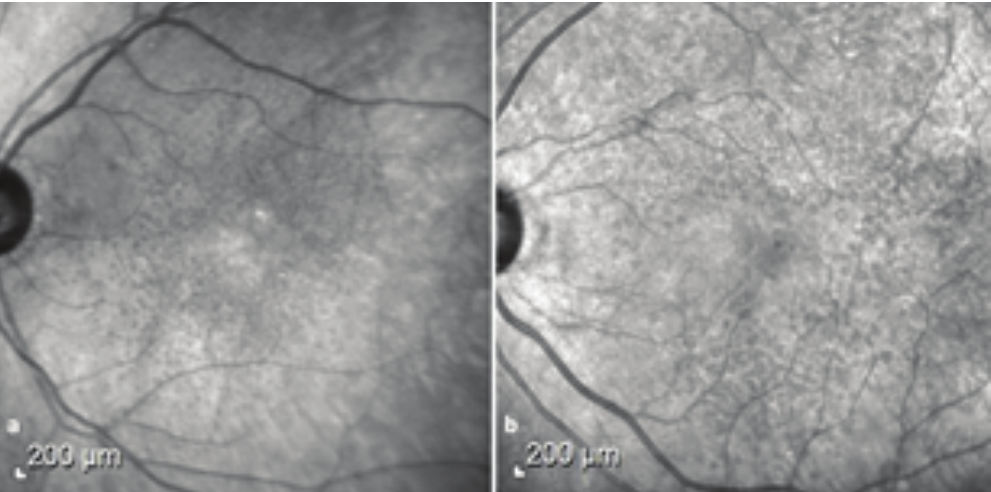
Figure 4. Near infra-red reflectance imaging of SDD. (a) Numerous clearly visible perifoveal SDD appearing as hyporeflective dots.